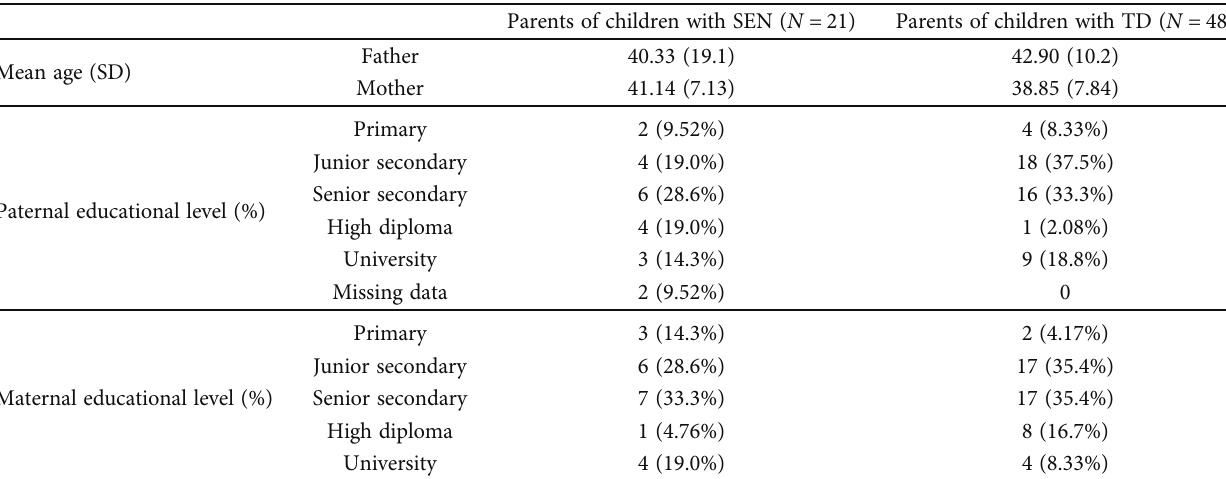
Table 2: Sociodemographic characteristics of parent